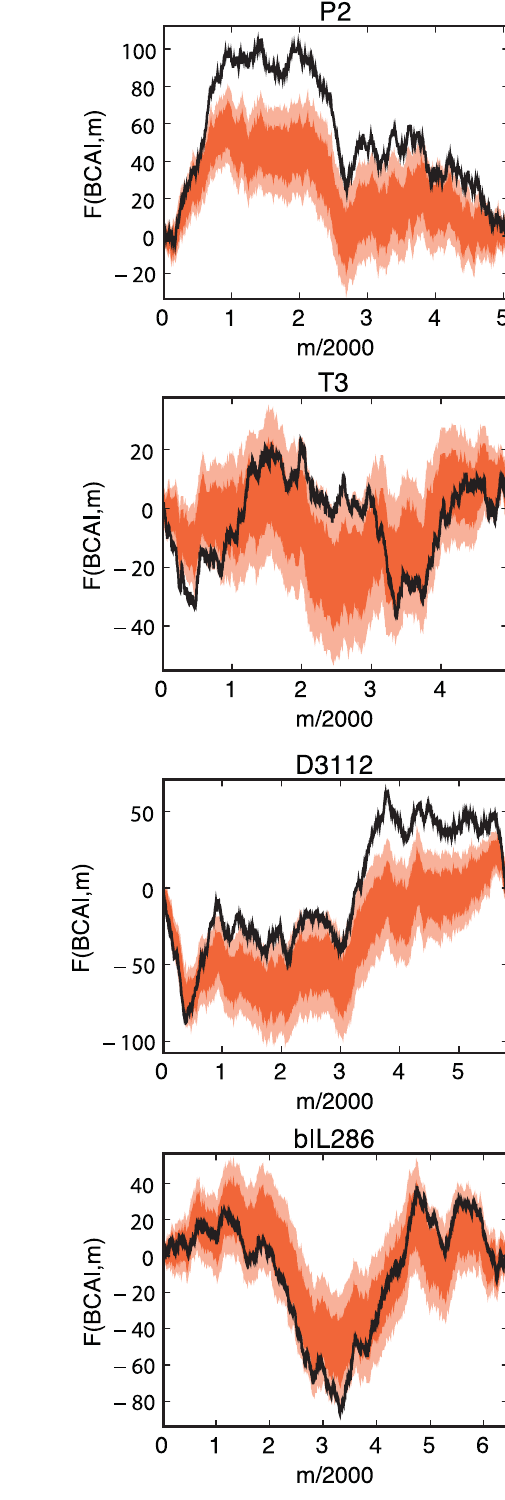
PLoS Computational Biology |